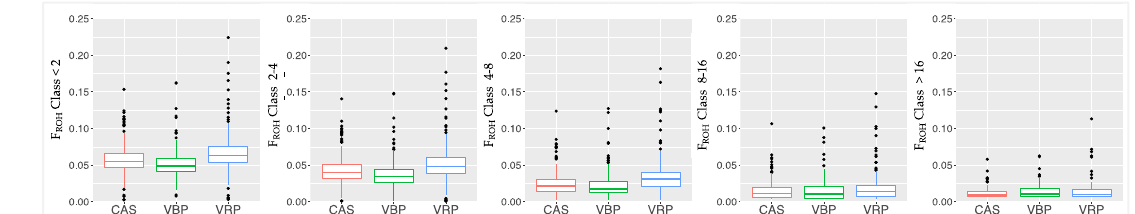
Figure 6. Boxplots built for each breed using the F ROH values calculated within the five classes of ROH length (Mb).